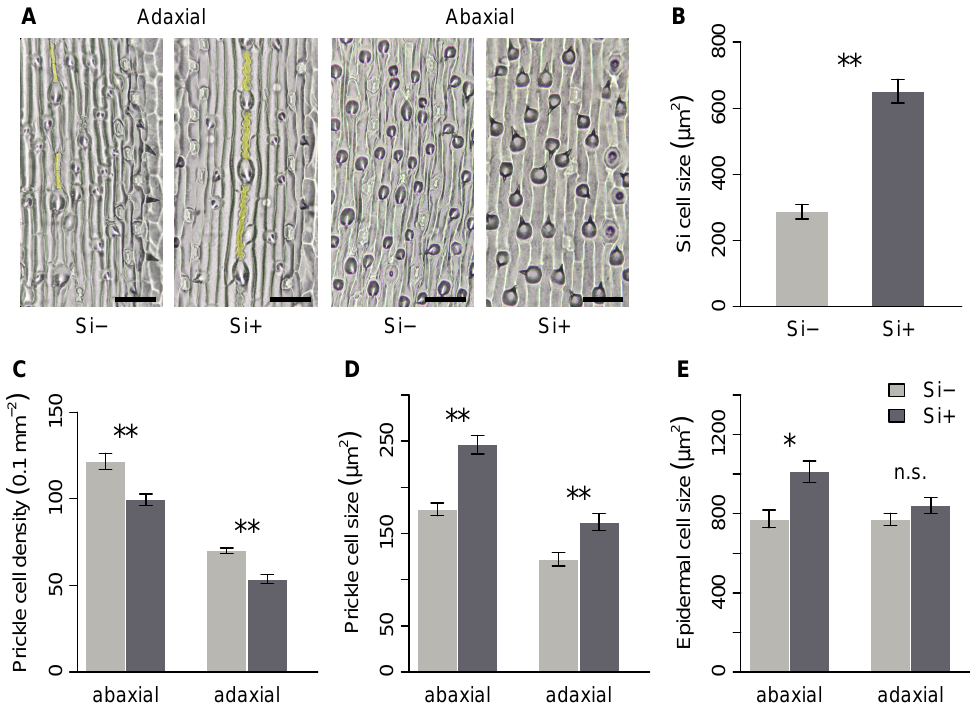
Figure 3. Brachypodium distachyon leaf surface morphology in response to Si supplementation. ( A ) images of adaxial and abaxial leaf surfaces; silica cells are false-coloured yellow, prickle cells are shown in dark grey, scale bars: 50 μ m. ( B ) Silica cell size, ( C ) prickle cell density, ( D ) prickle cell size and ( E ) epidermal cell size on Si+ and Si- plants ( n = 6). Values are means ± SE. Degrees of significance are indicated as follows: ns = not significant, * p < 0.05, ** p < 0.01.